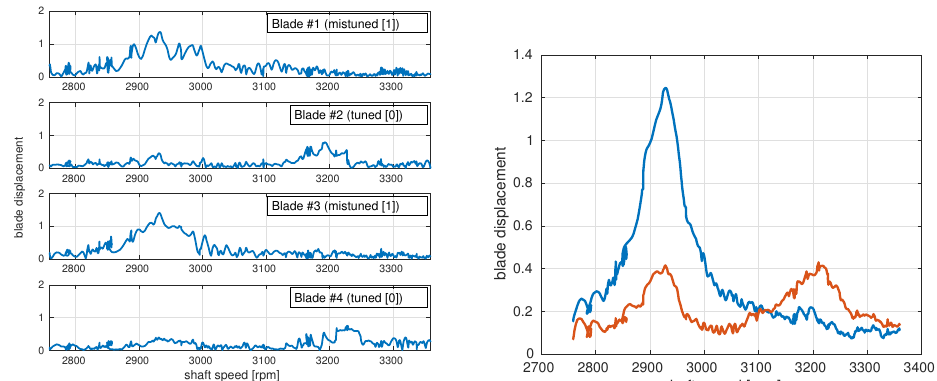
Figure 6. Experimentally measured blade displacement of the alternate mistuning configuration [01]. ( left ) Displacement of Blades 1–4. ( right ) Averaged displacement of tuned [0] (red) and mistuned [1] (blue)